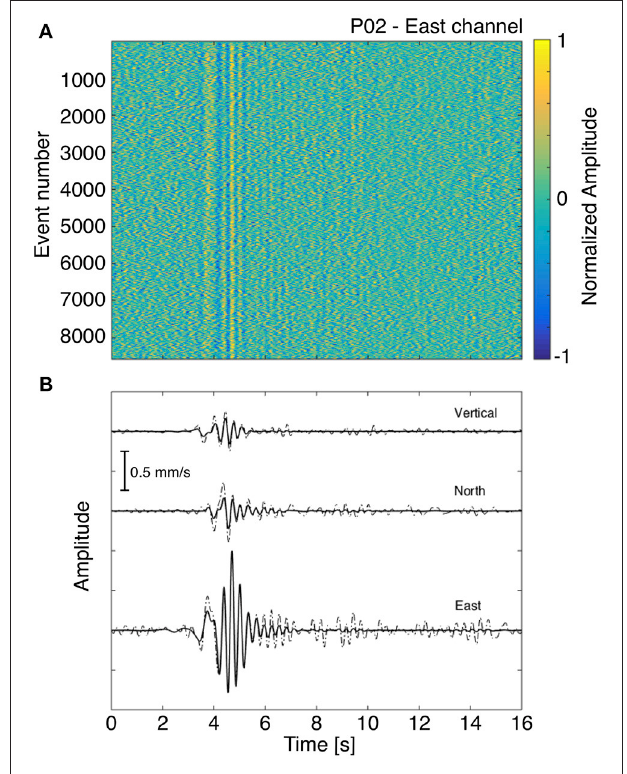
FIGURE 3 | (A) Waveforms of 8,587 seismic events with S/N greater than 1.2 observed on station P02 (east channel) over the same 10-day long period used for the infrasound detections. Waveforms are normalized to the maximum absolute amplitude. (B) Stacked seismograms for all three-components at station P02. Both linear time-domain (dashed lines) and phase-weighted stacks (bold lines) are